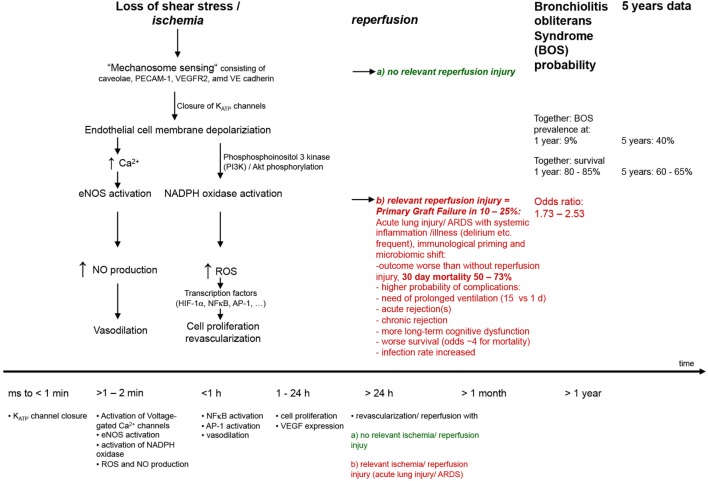
Pathophysiology and biological significance of pulmonary reimplantation response after lung transplantation (491–501). Adapted from Chatterjee et al (499), Whitson et al (496), Hartert et al (501), Basseri et al (498), Bharat et al (495), Bharat et al (497), Christie et al (492, 493), Huang et al (502), and King et al (491).